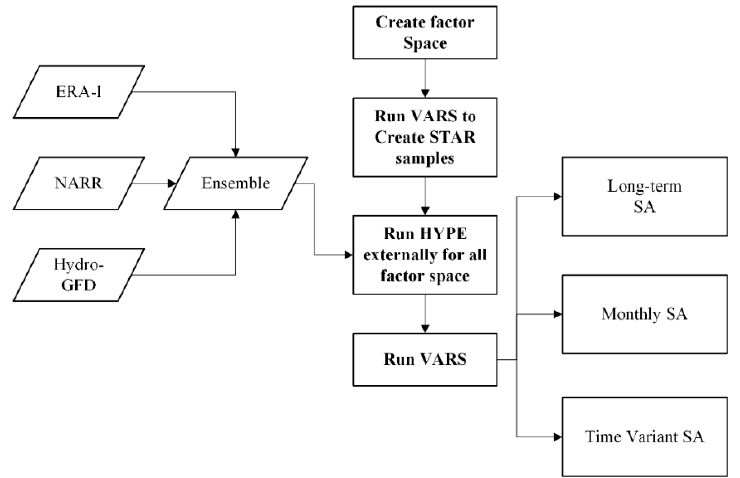
Figure 3. Methodological framework for time-variant sensitivity analysis of model parameters in HYPE.